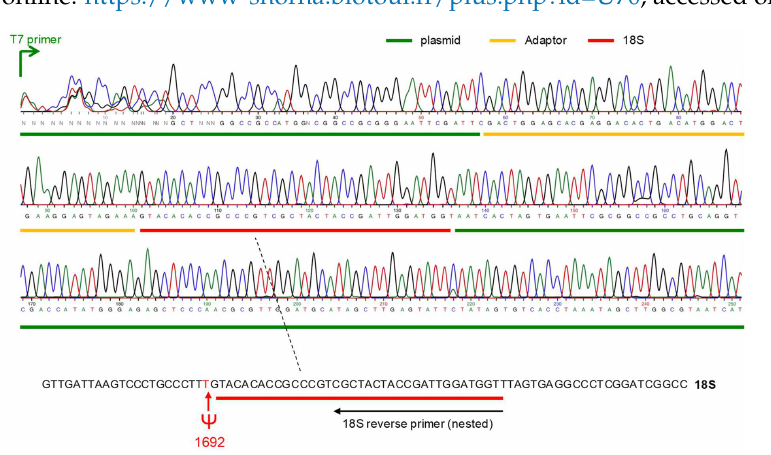
As shown in Figure 4, the sequencing of the PCR product retrieved the plasmid (green), the adaptor oligo (yellow), and the expected part of the 18S rRNA (red), and we were able to identify the correct U Psi site described previously (see [8]; snoRNABase, available online: https://www-snorna.biotoul.fr/plus.php?id=U70; accessed on 9 August 2022).